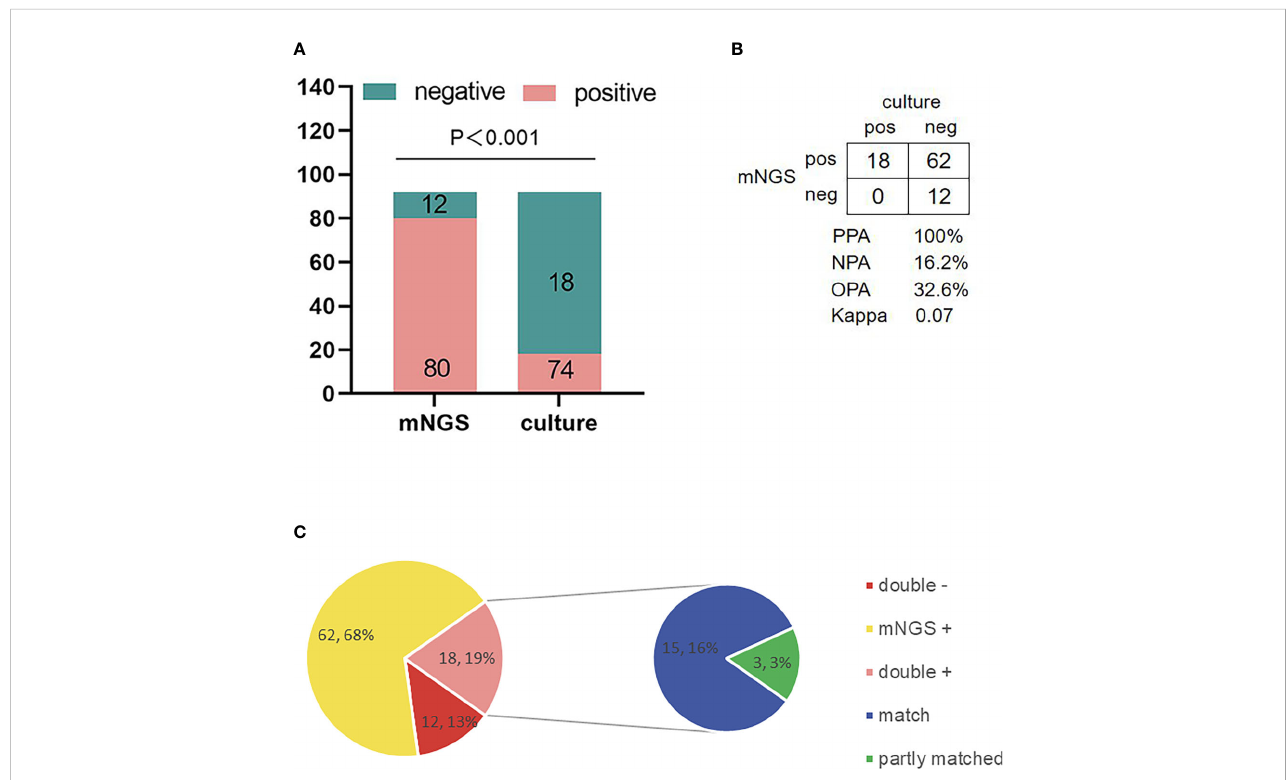
FIGURE 4 Comparison of the positive rate of metagenomic next-generation sequencing(mNGS) in spinal infection lesions and culture and analysis of the consistency of detection results. (A) The positive rate of mNGS was signi fi cantly higher than that of culture ( P < 0.001). (B) Contingency tables formatted in a 2 × 2 manner showing mNGS and culture being formatted in the diagnosis of pathogens of spinal infection, because the positive rate of culture was low (18/92, 19.57%). The consistency between the two methods was poor (Kappa=0.07). (C) The pie chart shows the matching situation between mNGS and positive culture results. Among 18 positive culture samples, the culture results of 15 samples are completely consistent with mNGS. Three samples were partially consistent (at least 1 pathogen identi fi ed in the test was con fi rmed by the other), and there was no con fl ict between mNGS and culture results. mNGS, metagenomic next-generation sequencing; PPA, positive percent agreement; NPA, negative percent agreement; OPA, overall percent